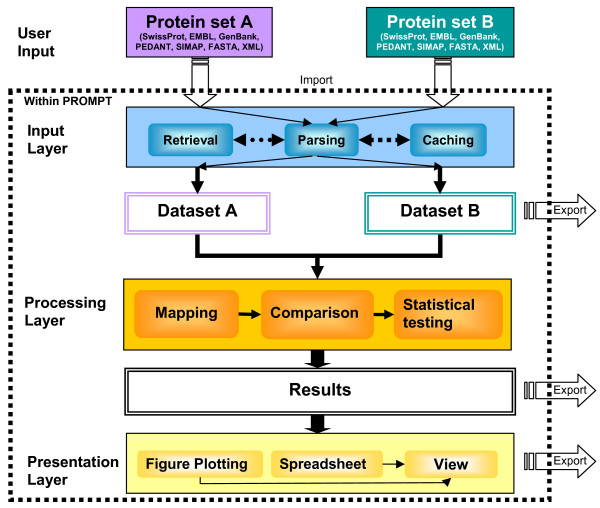
General Workflow of PROMPT.